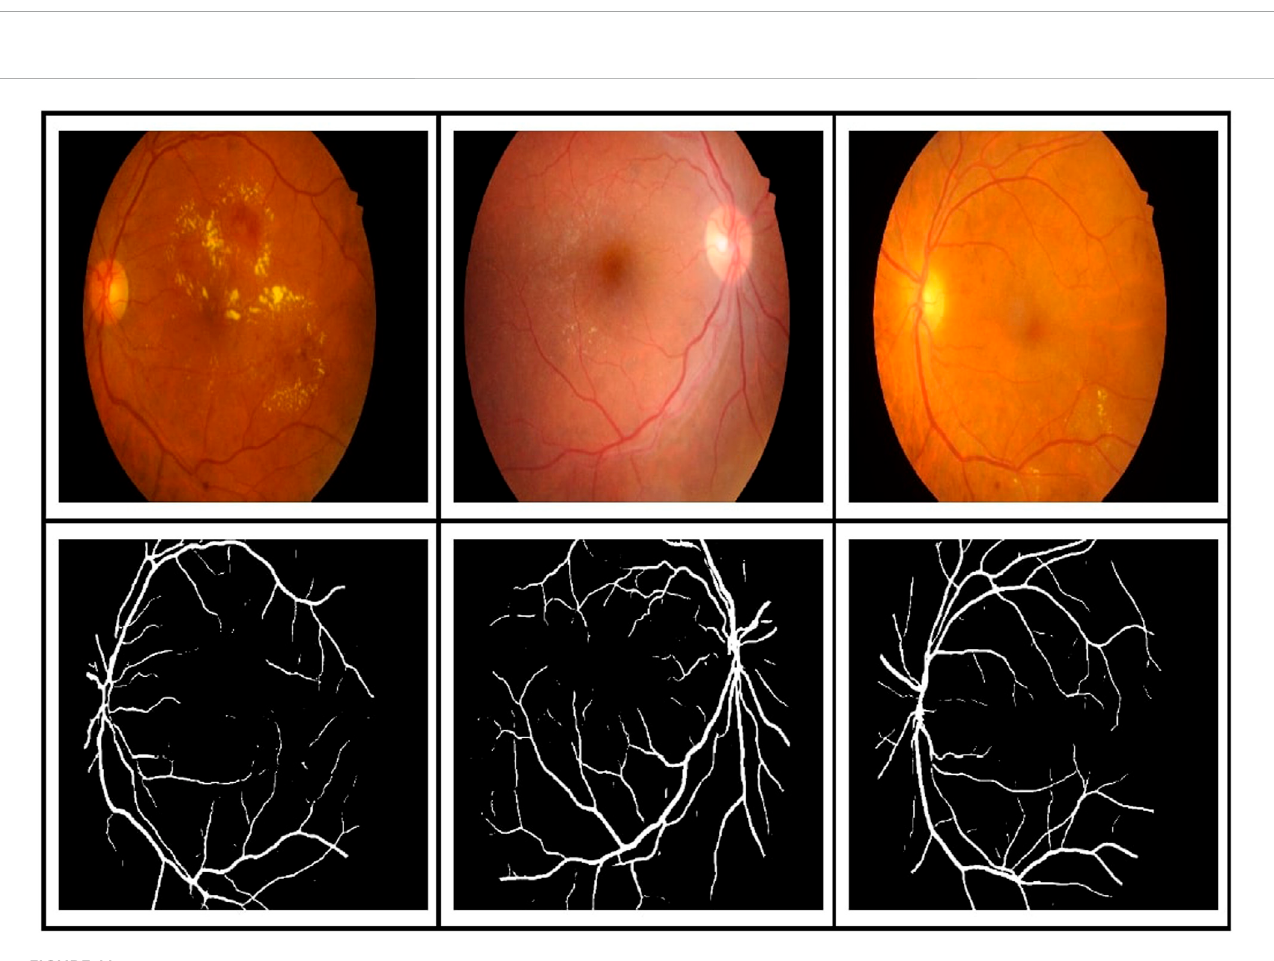
Frontiers in Signal